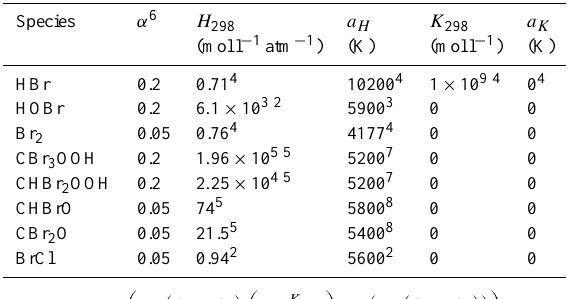
Table 1. Accommodation coefficients and values used in the deter- mination of the effective Henry’s constants H 1 X used in the